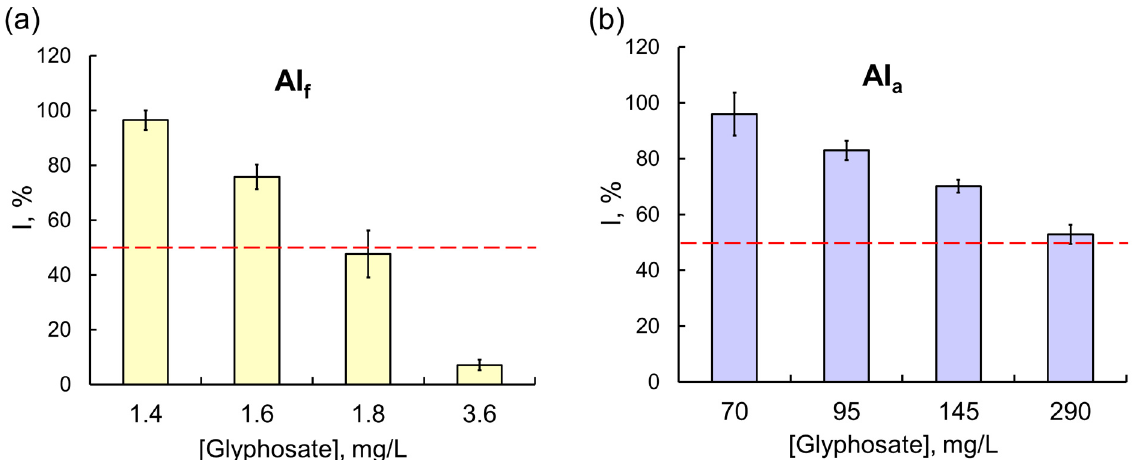
Figure 4. The effects of ( a ) the Tornado Extra commercial pesticide formulation (with glyphosate as the active ingredient) and ( b ) glyphosate as AIa on the Red + Luc coupled enzyme system. Glyphosate as AIf had a much stronger inhibitory effect on the Red + Luc assay system compared with glyphosate as AIa; the values of IC 50 for glyphosate as AIf and AIa were 1.8 and 288 mg/L, respectively.